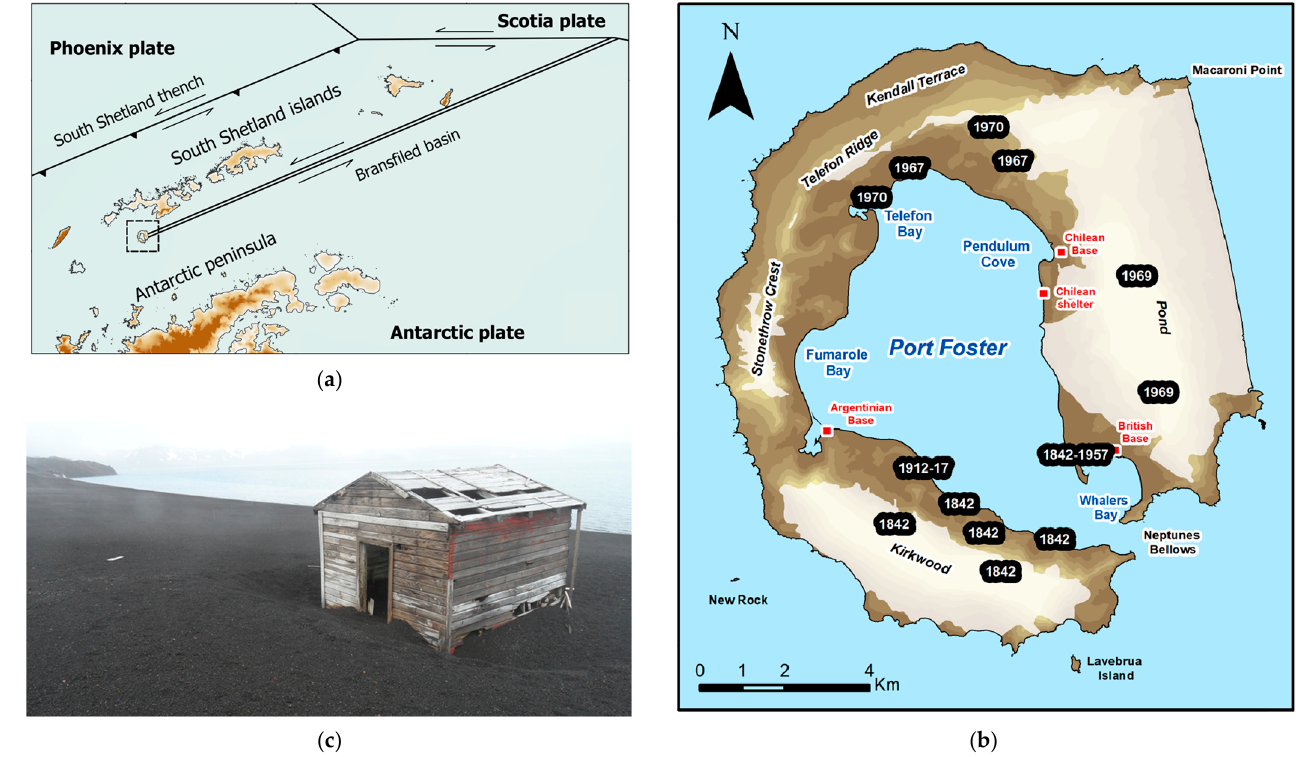
Figure 1. The South Shetland archipelago aligned NE–SW and nearly 100 km north of the Antarctic Peninsula and simplified tectonic surrounding [6] ( a ). Deception Island horseshoe-shape after the collapse of the caldera beneath sea level, connected to the ocean through a narrow and shallow passage. The location of the source of the 1967–1970 eruptive sequence events ( b ). Chilean shelter in 2012 still surrounded by ash fall from the 1967–1970 eruptions ( c ).